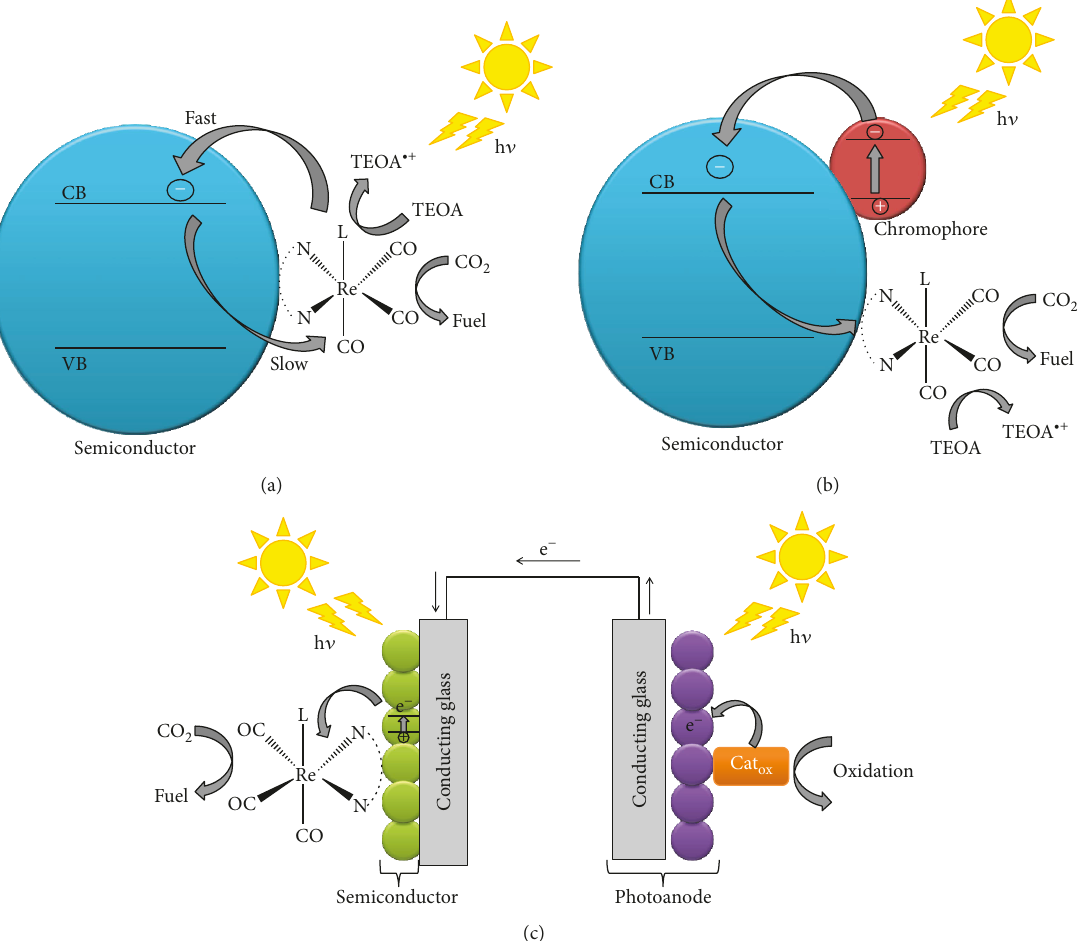
Figure 5: Work principle of hybrid Re(I)-based systems for CO reduction. (a) The Re(I) complex works simultaneously as light absorber and 2 catalytic center. (b) Chromophore and a Re(I) complex coadsorbed onto the metal oxide surface. (c) Re(I) catalyst immobilized on the surface of semiconductors with smaller band gaps in a